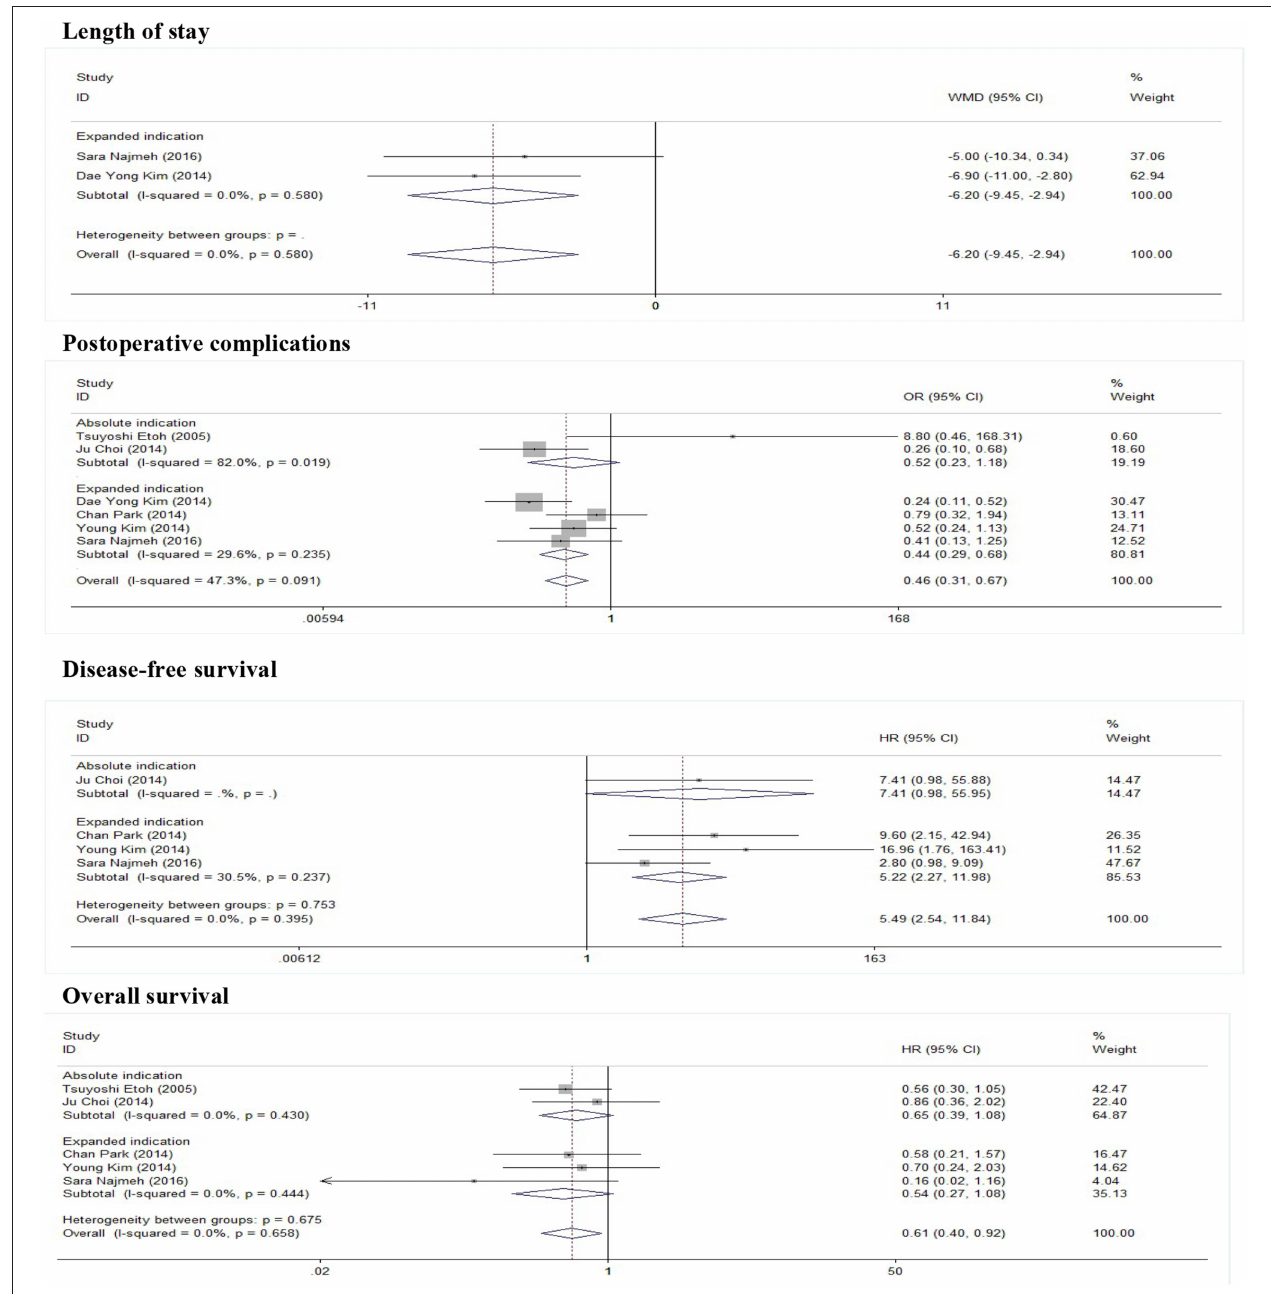
FIGURE 3 | Subgroup meta-analysis of indication for ER treatment.